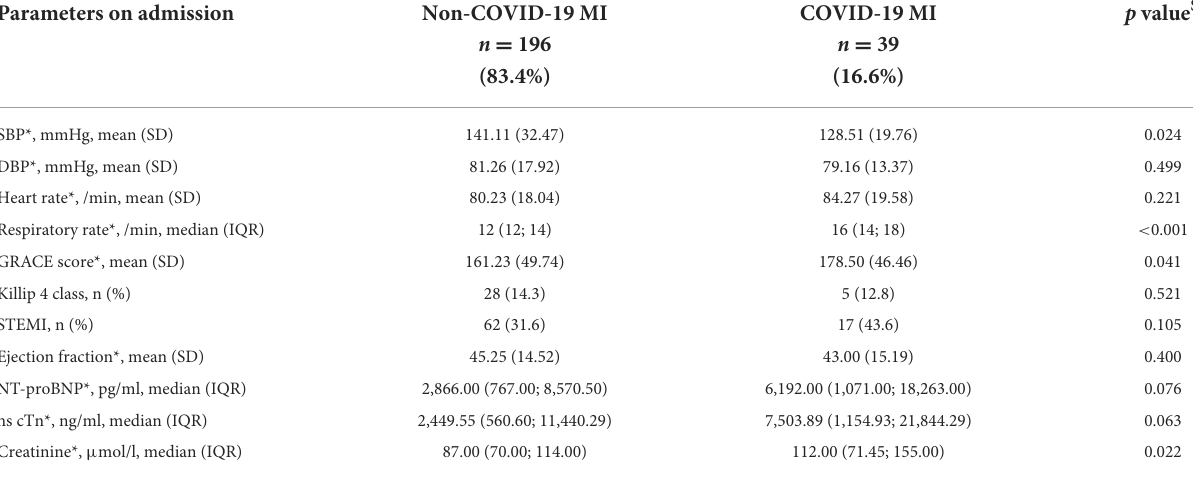
TABLE 2 Clinical characteristics on admission among non-COVID-19 MI and COVID-19 MI